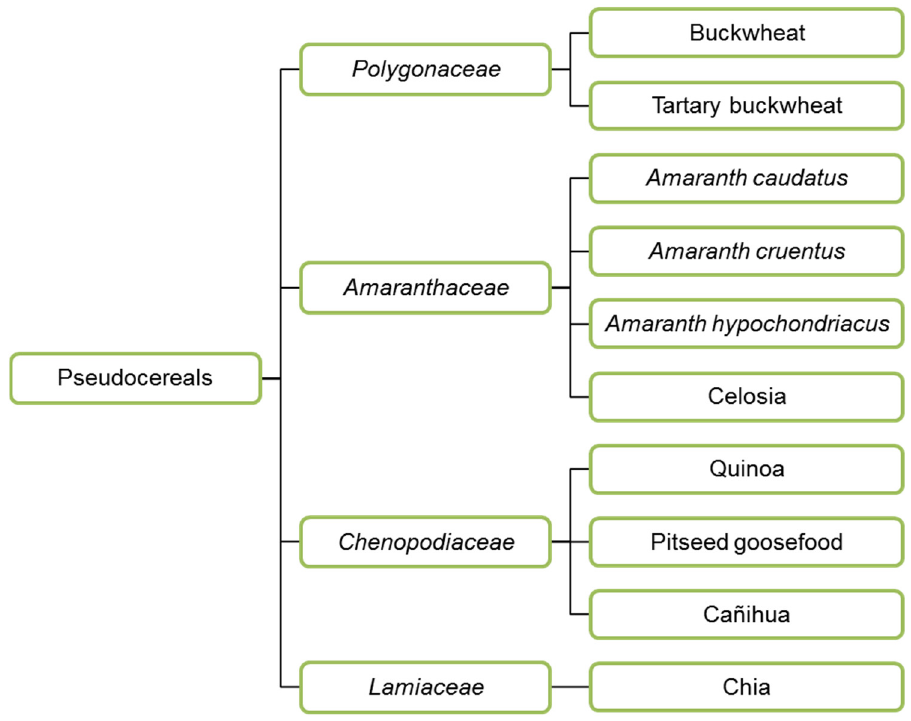
Figure 2. Taxonomy of pseudocereals.